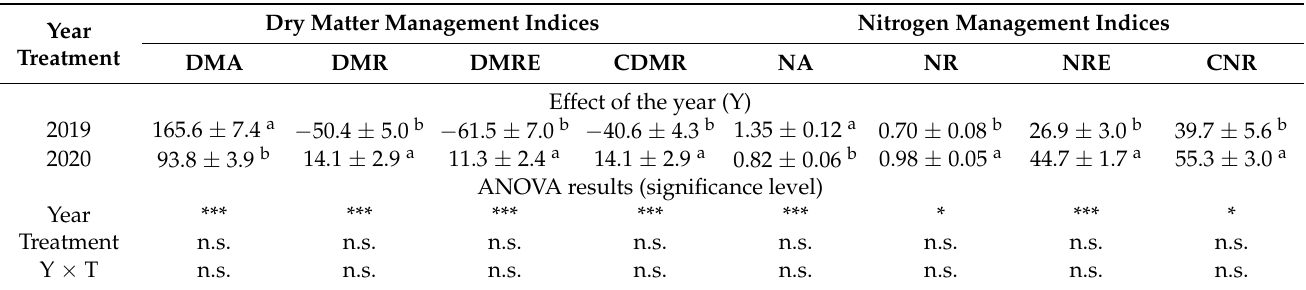
Table 4. Effect of the growing season and fertilization treatments on maize dry matter (DM) and nitrogen (N) management